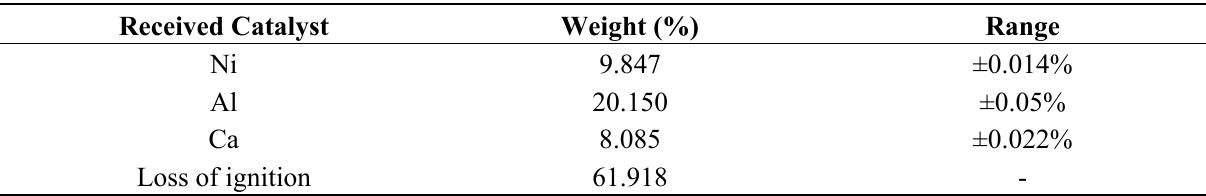
Table 2. X-ray fluorescence analysis